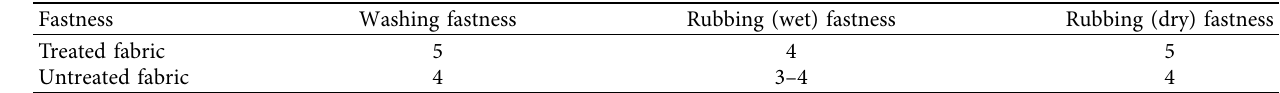
Figure 6: FTIR spectra of untreated fabric and treated fabric. Table 5: Wash and rub fastness of untreated and treated fabrics.